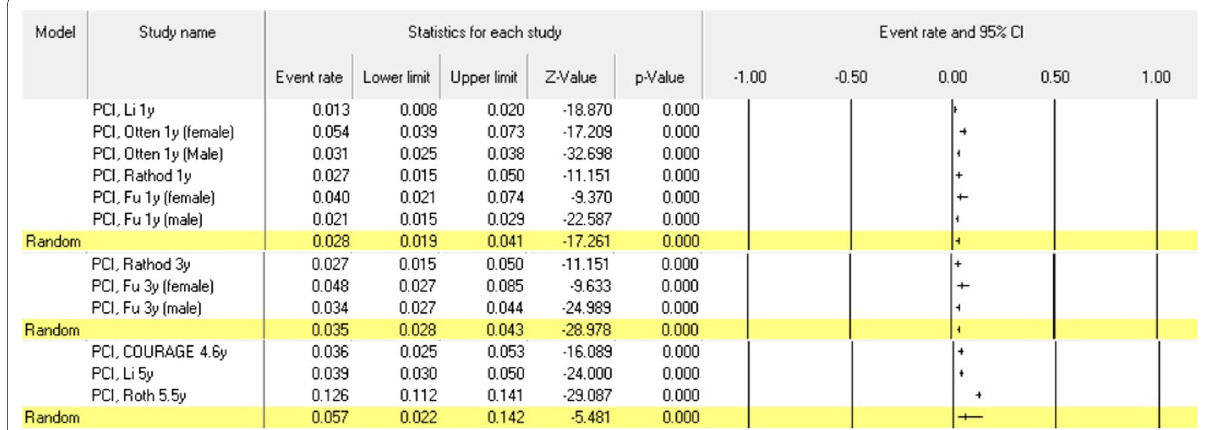
Fig. 3 Death probabilities after PCI in CAD patients under 60 years old at different follow-ups